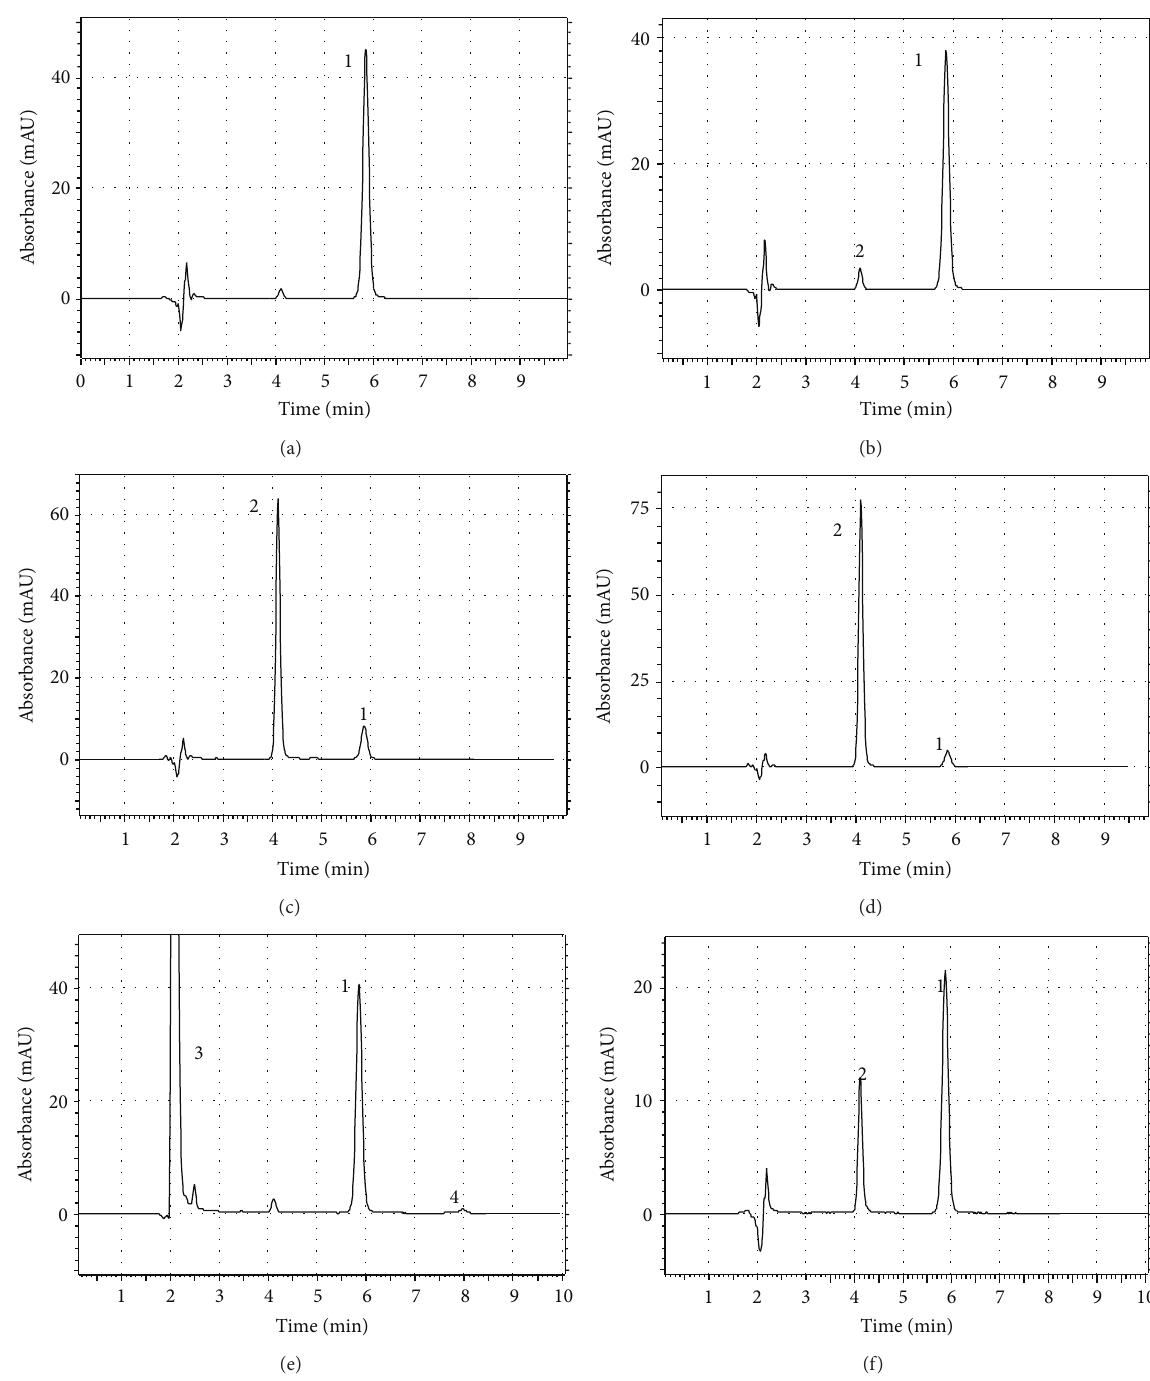
Figure 3: Typical chromatograms of (a) diltiazem working standard solution (10 𝜇 g/mL) and after degradation under (b) heat condition; (c) acidic hydrolysis; (d) basic hydrolysis; (e) oxidative condition: peak 3: hydrogen peroxide, peak 4: oxidative impurity; (f) photolytic condition: peak 1: diltiazem, peak 2: desacetyldiltiazem.